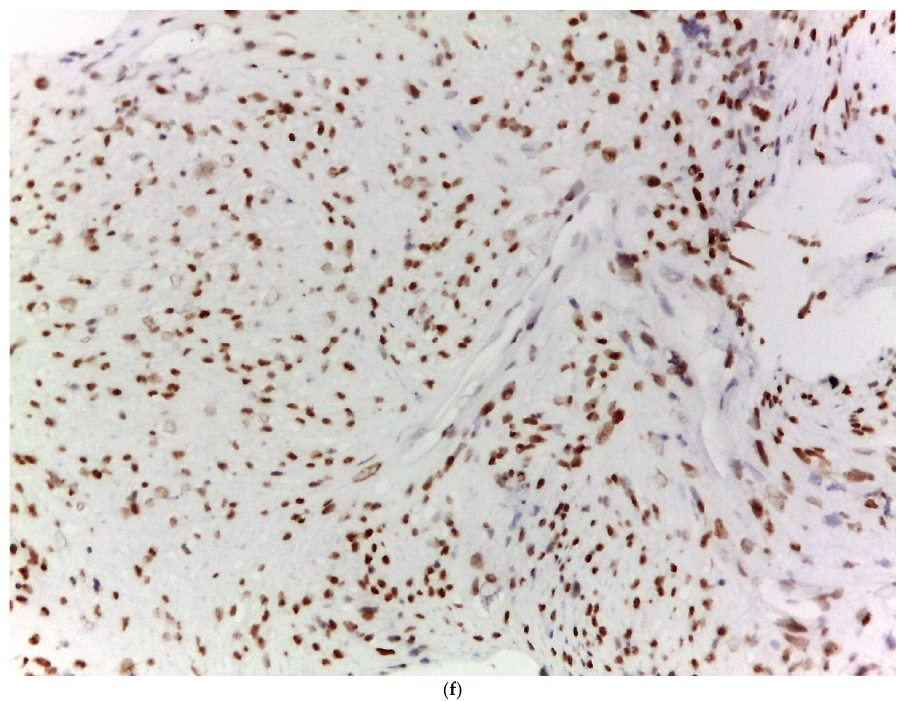
Figure 1. ( A ) Axial T1 fat ‐ saturated MRI shows soft tissue mass with peripheral high signal and internal low signal in the muscle anterior to the right shoulder. ( B ) Axial contrast ‐ enhanced CT scan Figure 1. ( a ) Axial T1 fat-saturated MRI shows soft tissue mass with peripheral high signal and shows a peripherally enhancing soft tissue mass located in the muscle, anterior to the right shoulder. Calcification is noted in the mass (arrow). ( C ) Macroscopically, the tumor is composed of tan − white internal low signal in the muscle anterior to the right shoulder. ( b ) Axial contrast-enhanced CT tissue with gritty zones corresponding to bone formation. On hematoxylin and eosin, a neoplastic scan shows a peripherally enhancing soft tissue mass located in the muscle, anterior to the right proliferation of atypical polygonal to spindle cells producing the malignant osteoid is evident (( D ) 100× magnification, ( E ) 200× magnification). A strong immunohistochemical nuclear expression of shoulder. Calcification is noted in the mass (arrow). ( c ) Macroscopically, the tumor is composed of SATB2 in neoplastic cells demonstrates the osteogenic differentiation and osteoid matrix production tan − white tissue with gritty zones corresponding to bone formation. On hematoxylin and eosin, of the neoplasm (( F ) 200× magnification). a neoplastic proliferation of atypical polygonal to spindle cells producing the malignant osteoid is Patients with localized ESOS account for 81–84% of all patients with ESOS [2,3]. The evident (( d ) 100 × magnification, ( e ) 200 × magnification). A strong immunohistochemical nuclear standard treatment for localized ESOS is wide resection, but the efficacy of adjuvant chem ‐ expression of SATB2 in neoplastic cells demonstrates the osteogenic differentiation and osteoid matrix otherapy remains controversial [4]. According to the ESMO ‐ EURACAN ‐ GENTURIS ‐ ERN PaedCan Clinical Practice Guideline for the diagnosis, treatment, and follow ‐ up of pa ‐ production of the neoplasm (( f ) 200 × tients with soft tissue sarcomas, ESOS is considered a high ‐ grade soft tissue sarcoma with questionable clinical similarity to osteosarcoma and adjuvant chemotherapy provides lim ‐ ited benefit [5]. In contrast, according to the National Comprehensive Cancer Network guidelines, ESOS can be treated with adjuvant chemotherapy using ifosfamide or plati ‐ num ‐ based therapy (cisplatin/doxorubicin) [6]. In addition, the appropriate chemother ‐ apy regimen for bone or soft tissue sarcomas remains controversial [2,7–9]. Because ESOS rarely occurs, only retrospective studies have been conducted and no randomized con ‐ trolled trials (RCTs) have examined the effect of (neo)adjuvant chemotherapy on localized ESOS. Therefore, the effect of (neo)adjuvant chemotherapy on localized ESOS remains unclear. To investigate the effect of (neo)adjuvant chemotherapy on localized ESOS, we